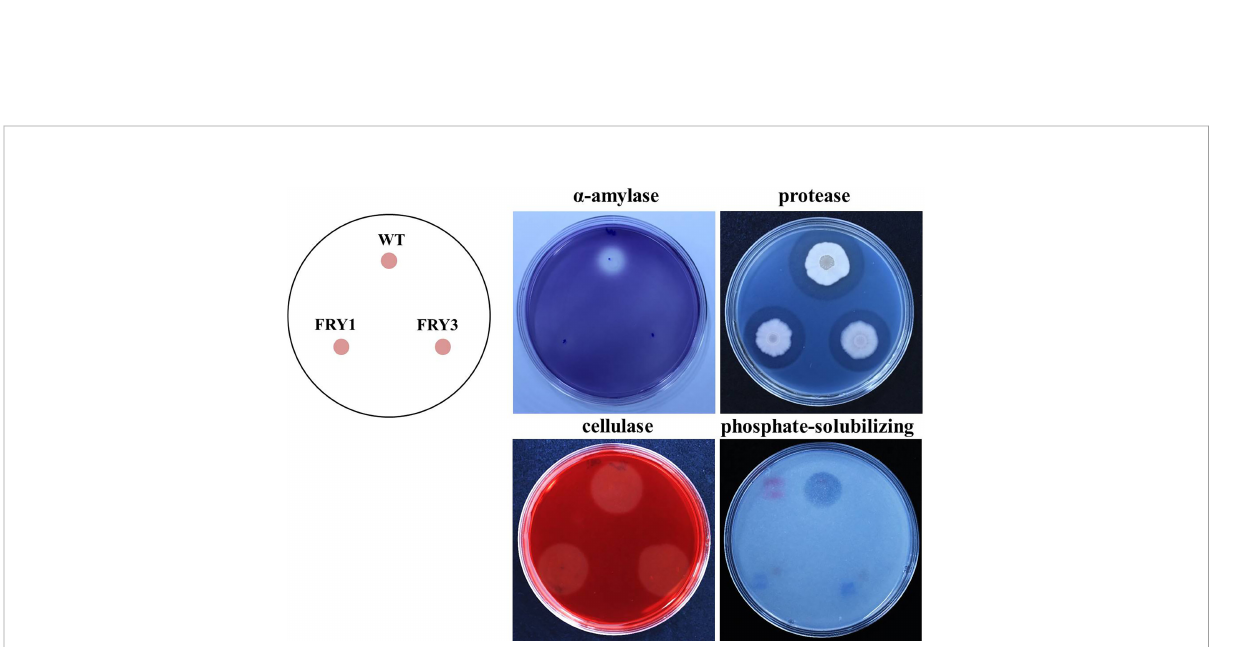
FIGURE 11 The enzyme activity of a -amylase and protease, and phosphate-solubilizing ability of D srf mutants were decreased. Three microliters of strains (OD 600 = 1) were inoculated on media testing a -amylase, protease, cellulase and phosphate-solubilizing ability and incubated at 37°C for 2 days ( a -amylase, protease, cellulase) or 5 days (phosphate-solubilizing).